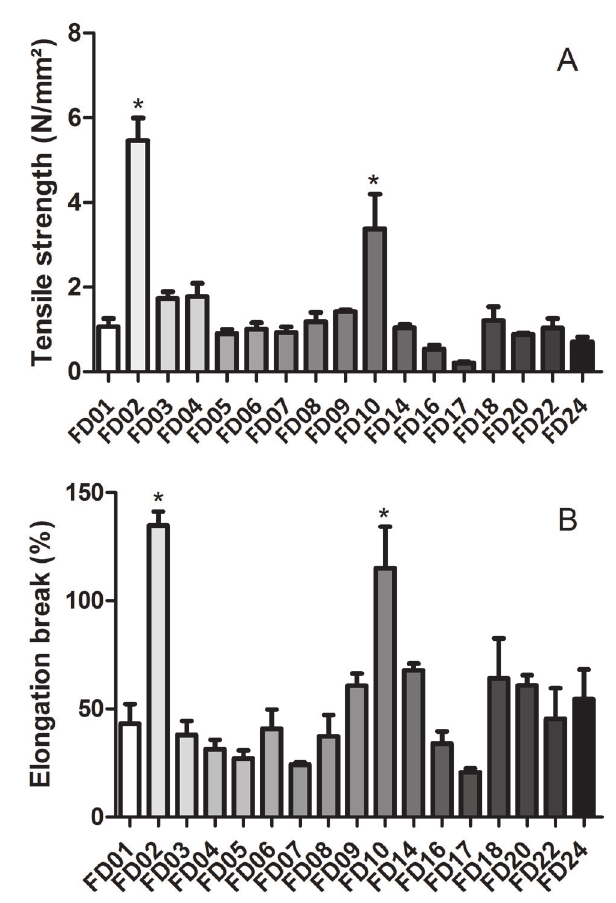
FIGURE 3 - Comparison of A) tensile strength (N/mm²) and B) elongation at break (%) of obtained films.